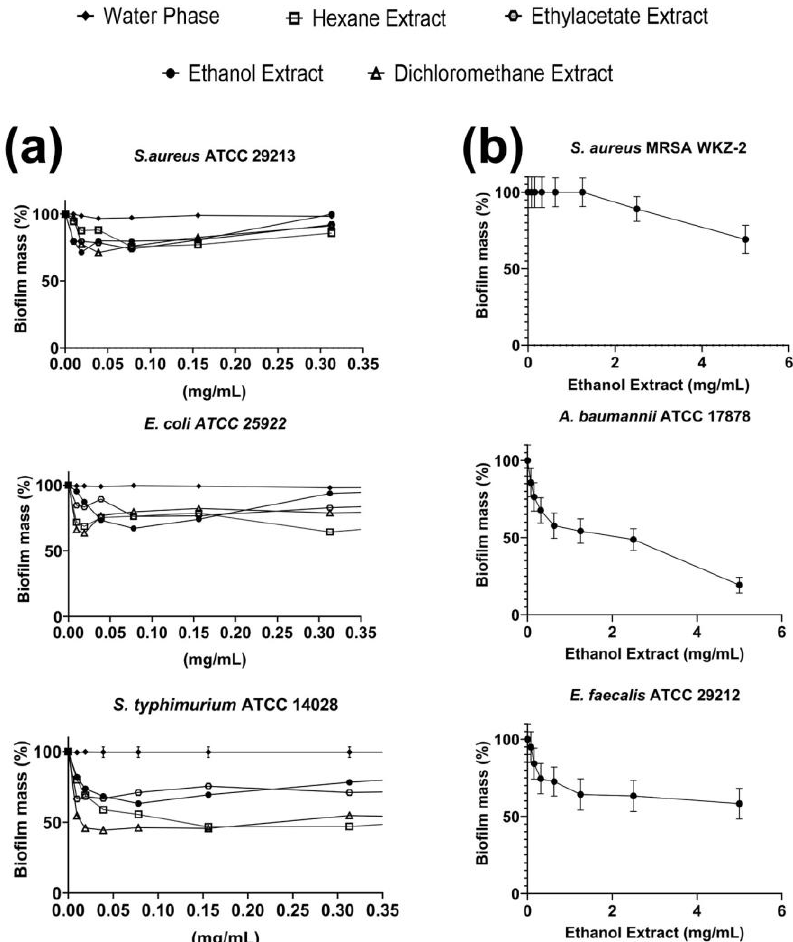
Figure 1. Antibiofilm activity of E. foeminea plant extracts on S. aureus ATCC 29213, S. aureus MRSA WKZ-2, E. faecalis ATCC 29212, A. baumannii ATCC 17878, E. coli ATCC 25922 and S. typhimurium ATCC 14028. ( a ) Extracts obtained in ethanol, hexane, dichloromethane, ethyl acetate or water phase were tested against S. aureus ATCC 29213, E. coli ATCC 25922 and S. typhimurium ATCC 14028. ( b ) Ethanolic extract was tested against A. baumannii ATCC 17878, E. faecalis ATCC 29212 and S. aureus MRSA WKZ-2. The effects of increasing concentrations of each extract were evaluated on biofilm formation. At the end of the incubations, biofilm samples were stained with crystal violet and measured at 630 nm. Data represent the mean ( ± standard deviation, SD) of at least three independent experiments, each one carried out with triplicate determinations.